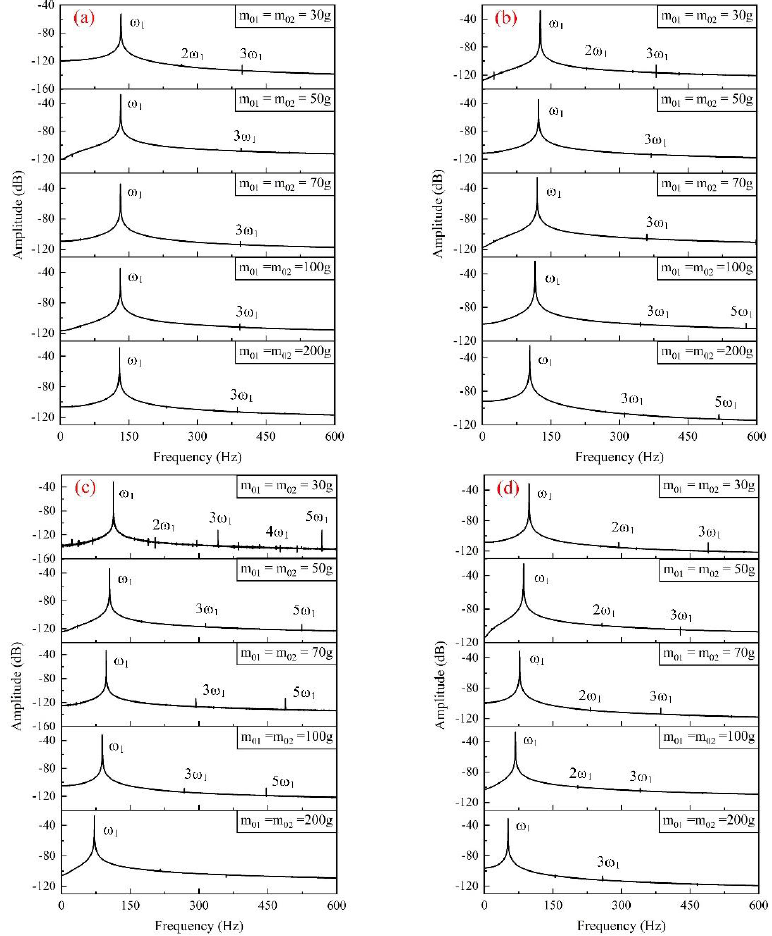
Figure 5. Vibration spectrograms of coupling system with symmetric additional masses of different weight in different location. ( a ) Symmetric additional masses (top to bottom: 30 g, 50 g, 70 g, 100 g,